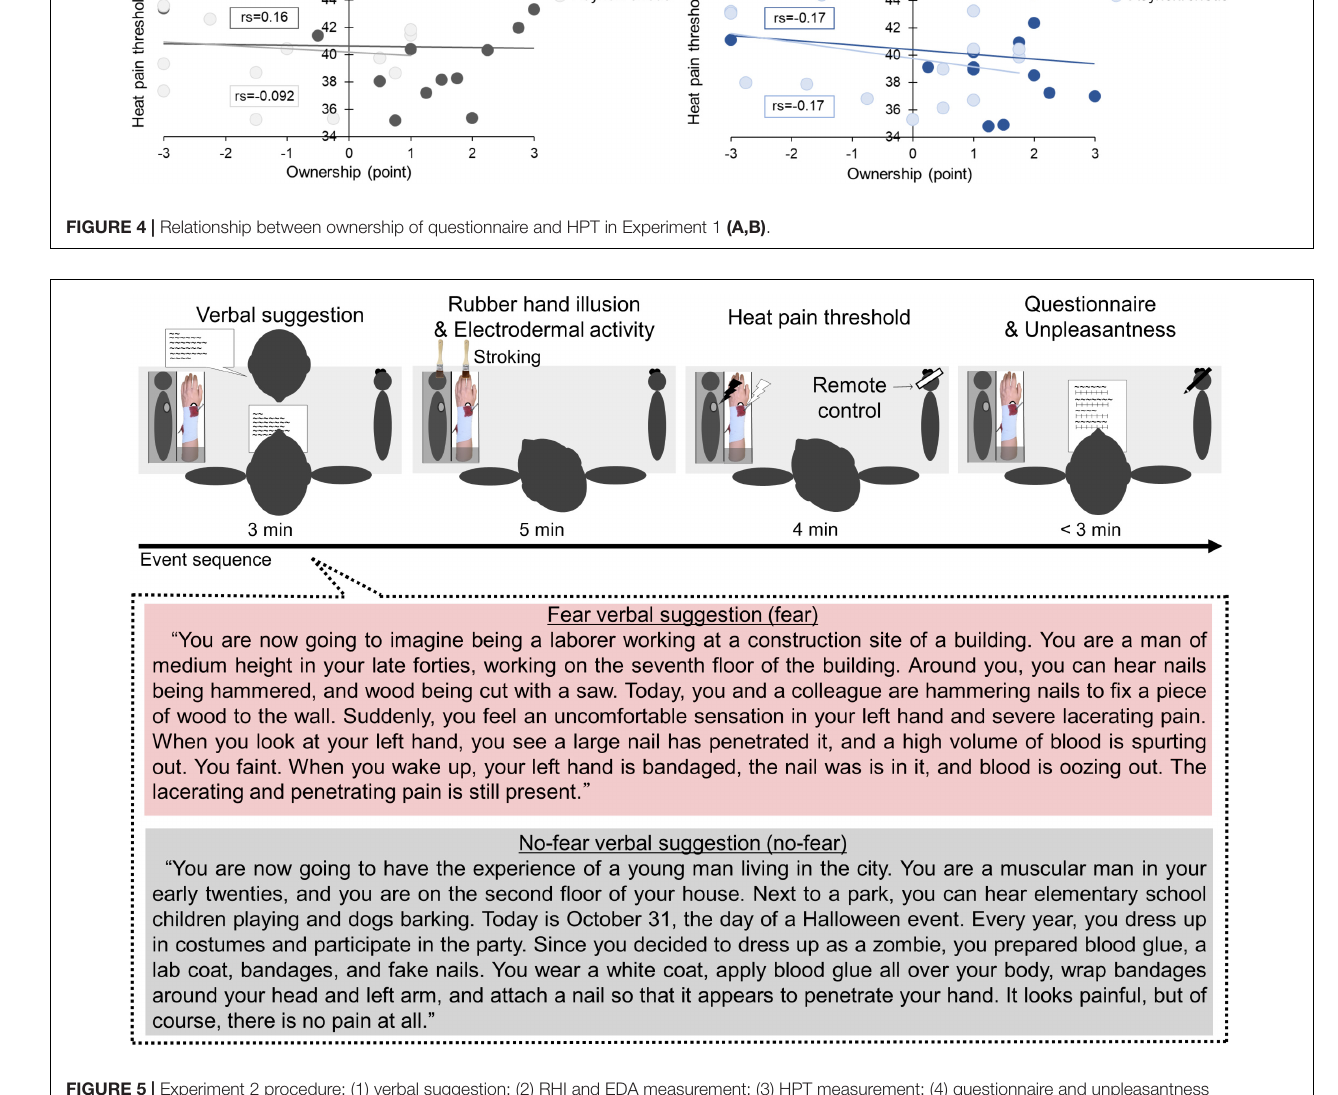
FIGURE 5 | Experiment 2 procedure: (1) verbal suggestion; (2) RHI and EDA measurement; (3) HPT measurement; (4) questionnaire and unpleasantness measurement [(B) Top]. Verbal suggestion: fear verbal suggestion (fear) and no-fear verbal suggestion (no-fear) comprised approximately 280 Japanese characters each [(B)